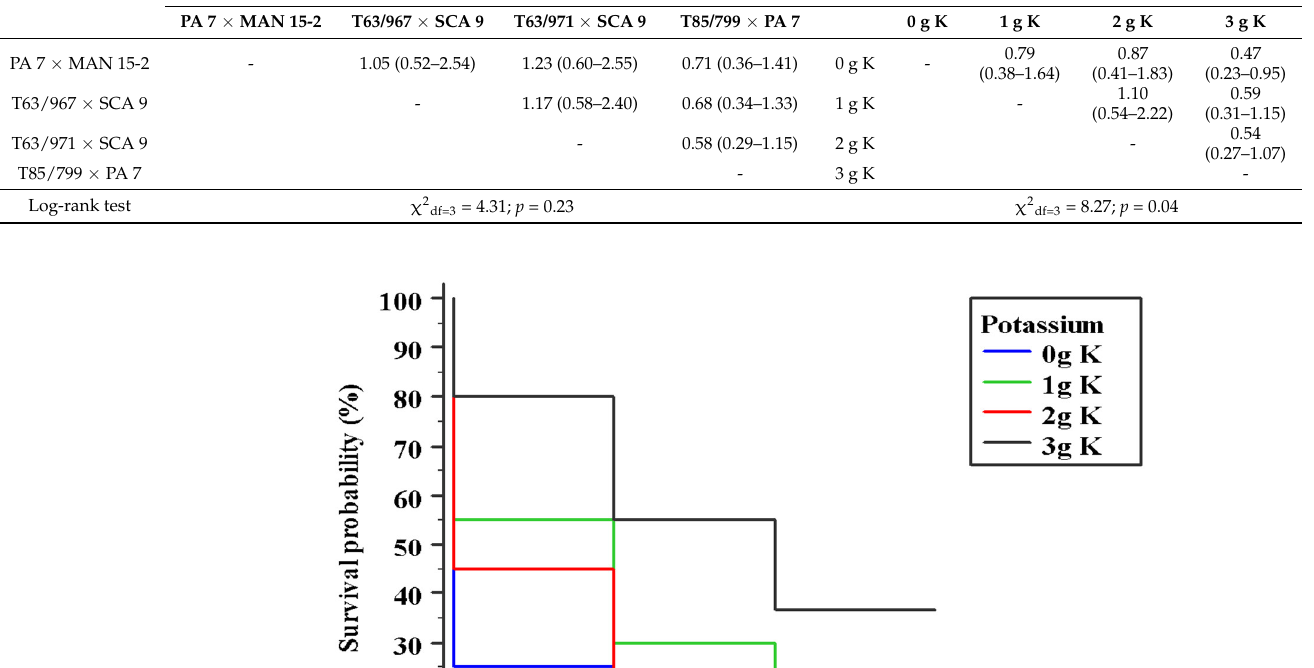
Table 7. Hazard ratios from the Kaplan–Meier survival analyses for cocoa seedlings under soil water stress conditions as affected by variety and potassium application in experiment 1. Hazard Ratios for Varieties (95% Confidence Intervals) Hazard Ratios for K Levels (95% Confidence Intervals)